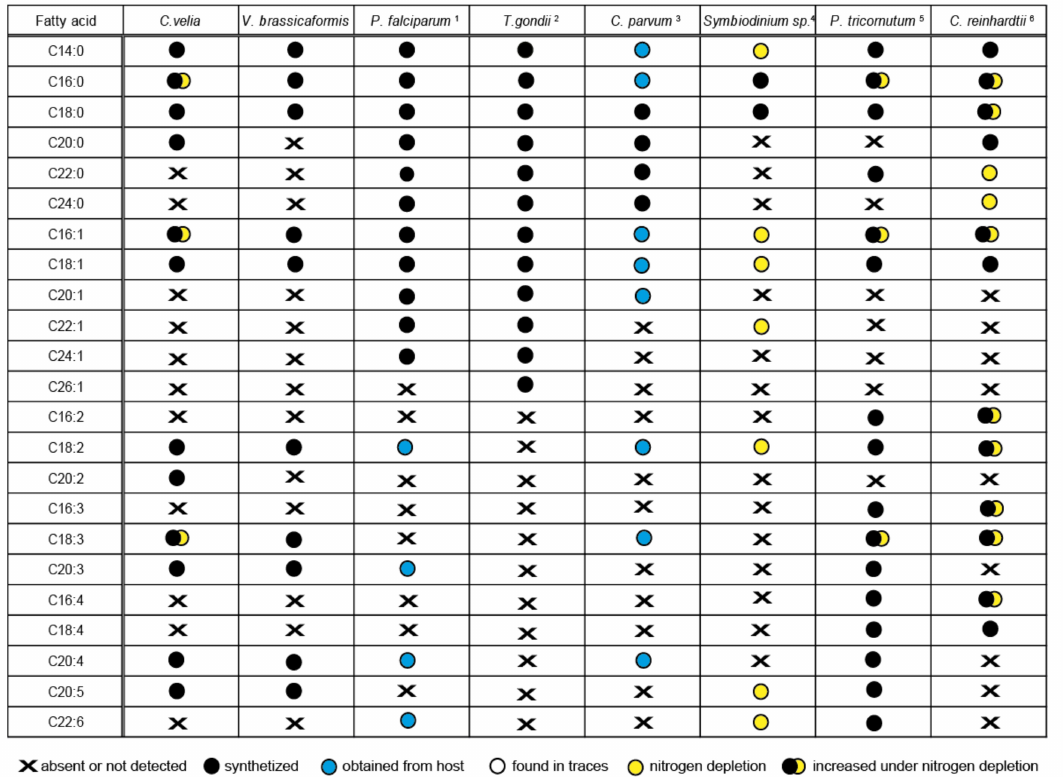
Figure 8. Comparison of the fatty acid profile of particular organisms and the origin of particular fatty acids. Liver-stage of Plasmodium , intracellular stages of Toxoplasma gondii (1) Bott é et al., 2013 [54], (2) Ramakrishnan et al., 2012, 2015 [52,55], (3) Mitschler et al., 1994 [56], (4) Weng at al., 2014 [57], (5) Siron et al., 1989; Popko et al., 2016 [58,59], (6) James et al., 2011; Puzanskiy et al., 2015